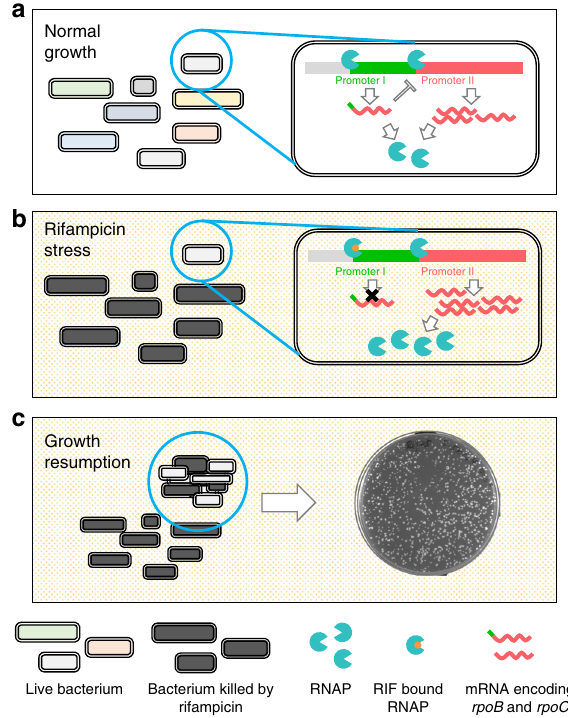
Fig. 6 Working model of transcriptional regulation of rpoB-rpoC in mycobacteria and its role in rifampicin-speci fi c phenotypic resistance. a Under normal growth conditions, maximal rpoB expression is suppressed by the interaction of the promoters in the rpoB-rpoC operon. Expression